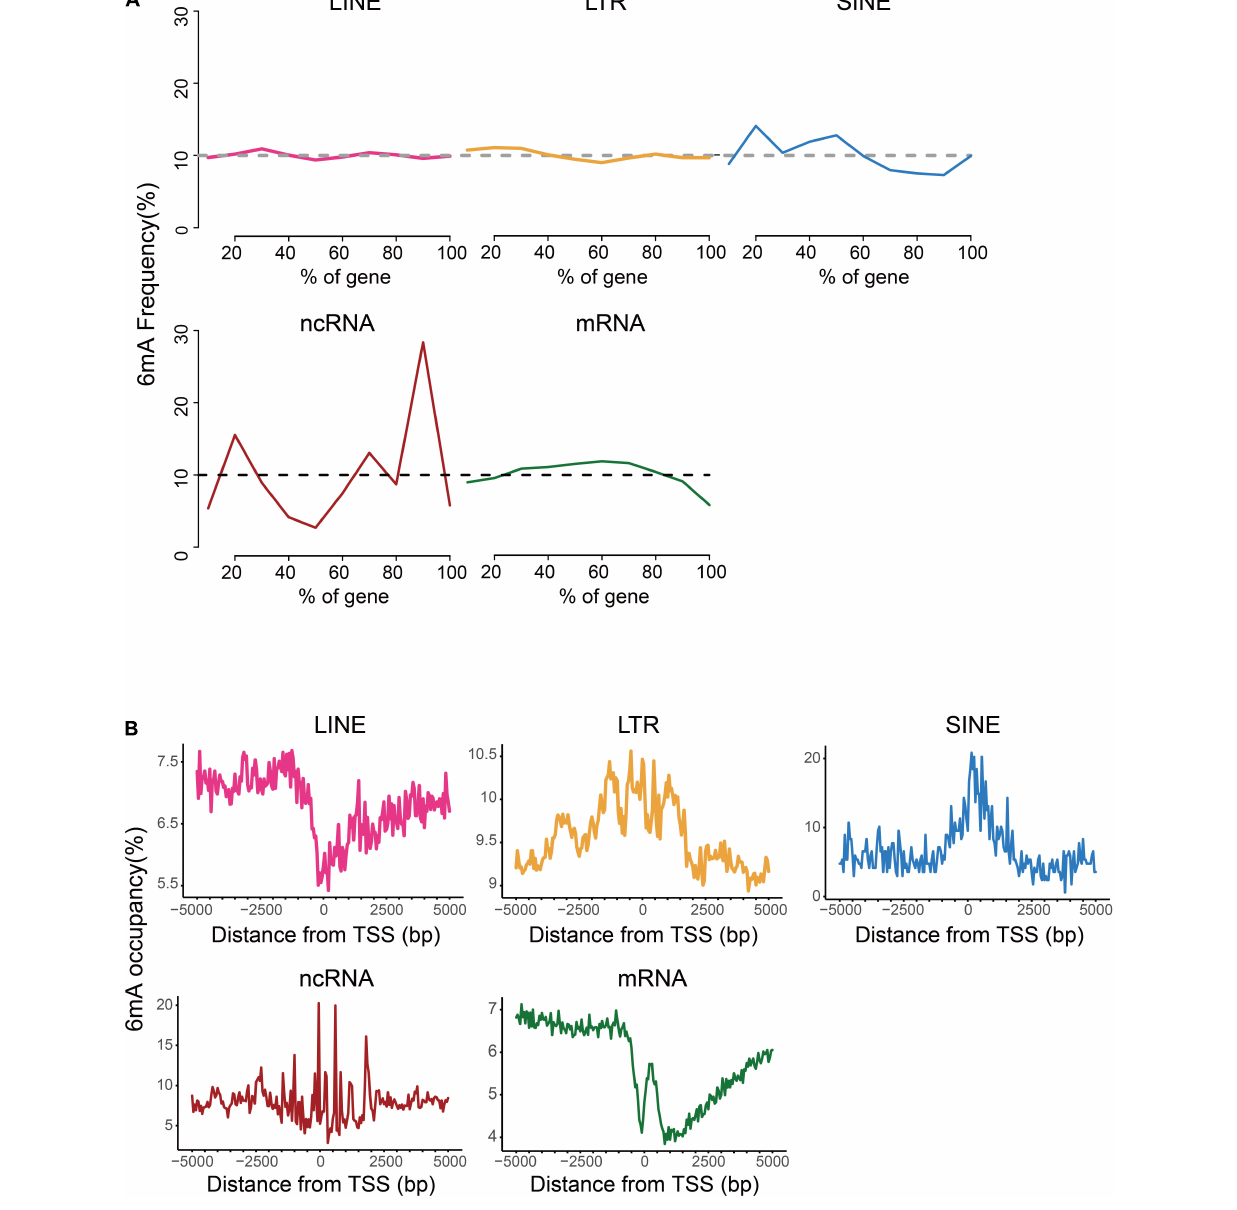
FIGURE 3 | Distribution patterns of 6mA in echo type of genes. (A) Frequency of 6mA sites at relative positions in gene bodies. (B) Distribution of 6mA occupancy around the transcription start site